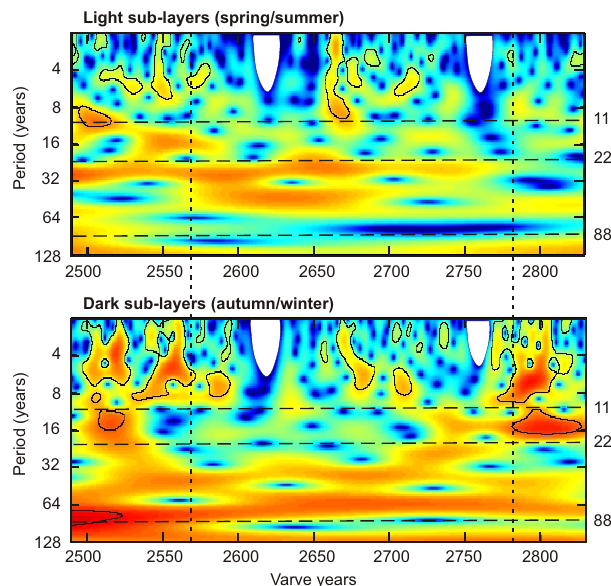
Fig. 7. Wavelet power spectra of the light and dark sub-layer thick- ness measurements spanning the OHO interval. Wavelet amplitudes are colour coded from red (high power) to blue (low power). Con- toured areas exceed the 95% confidence levels for a red noise back- ground spectrum. Vertical dashed lines mark the boundaries of the OHO at 2565 and 2782 varve years. Horizontal dashed lines indi- cate the solar-like periodicities. White cones indicate intervals with no varve-thickness